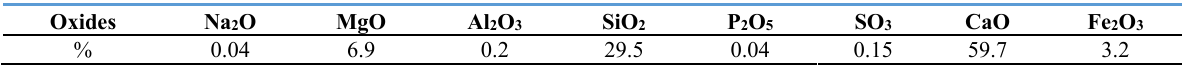
Table 2. Chemical composition of tailings.